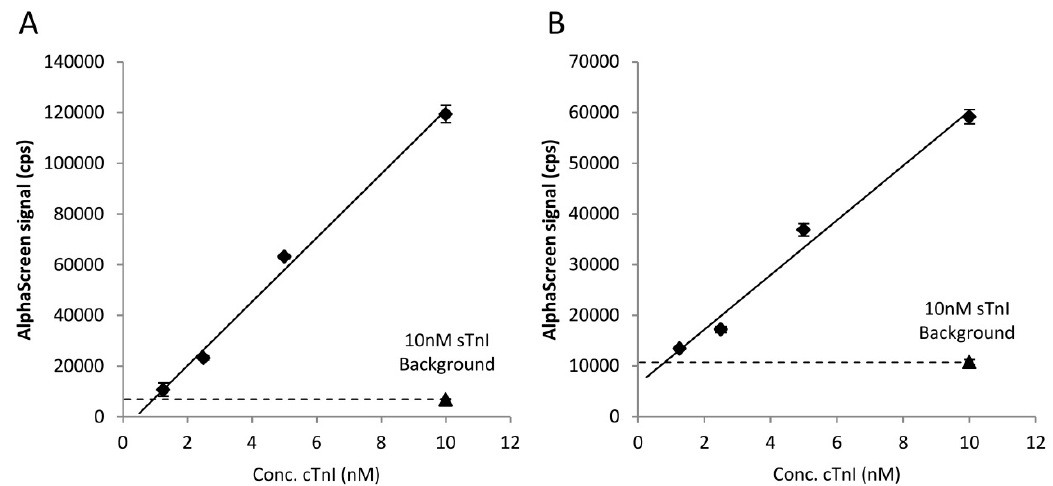
Figure 4. AlphaLisa signal of the sandwich assay as a function of the concentration of cTnI. The selection buffer ( A ) or diluted serum ( B ) was formulated with various amounts of recombinant cTnI or sTnI to reach the indicated final concentrations. The signals were measured by a fluorescence plate reader. The adjusted R-squared values were 0.9945 and 0.9843, respectively.